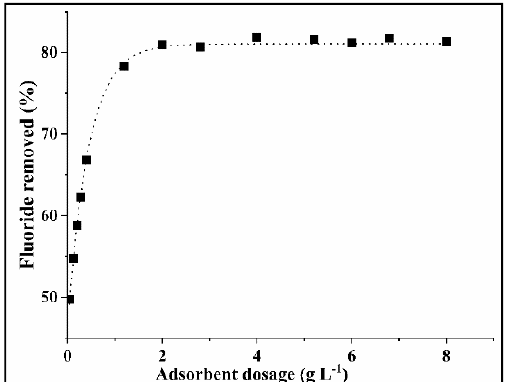
Figure 4. Percentage of fluoride removal over different COMA dosages in the absence of calcium (initial fluoride concentration: 15 mg L − 1 ).